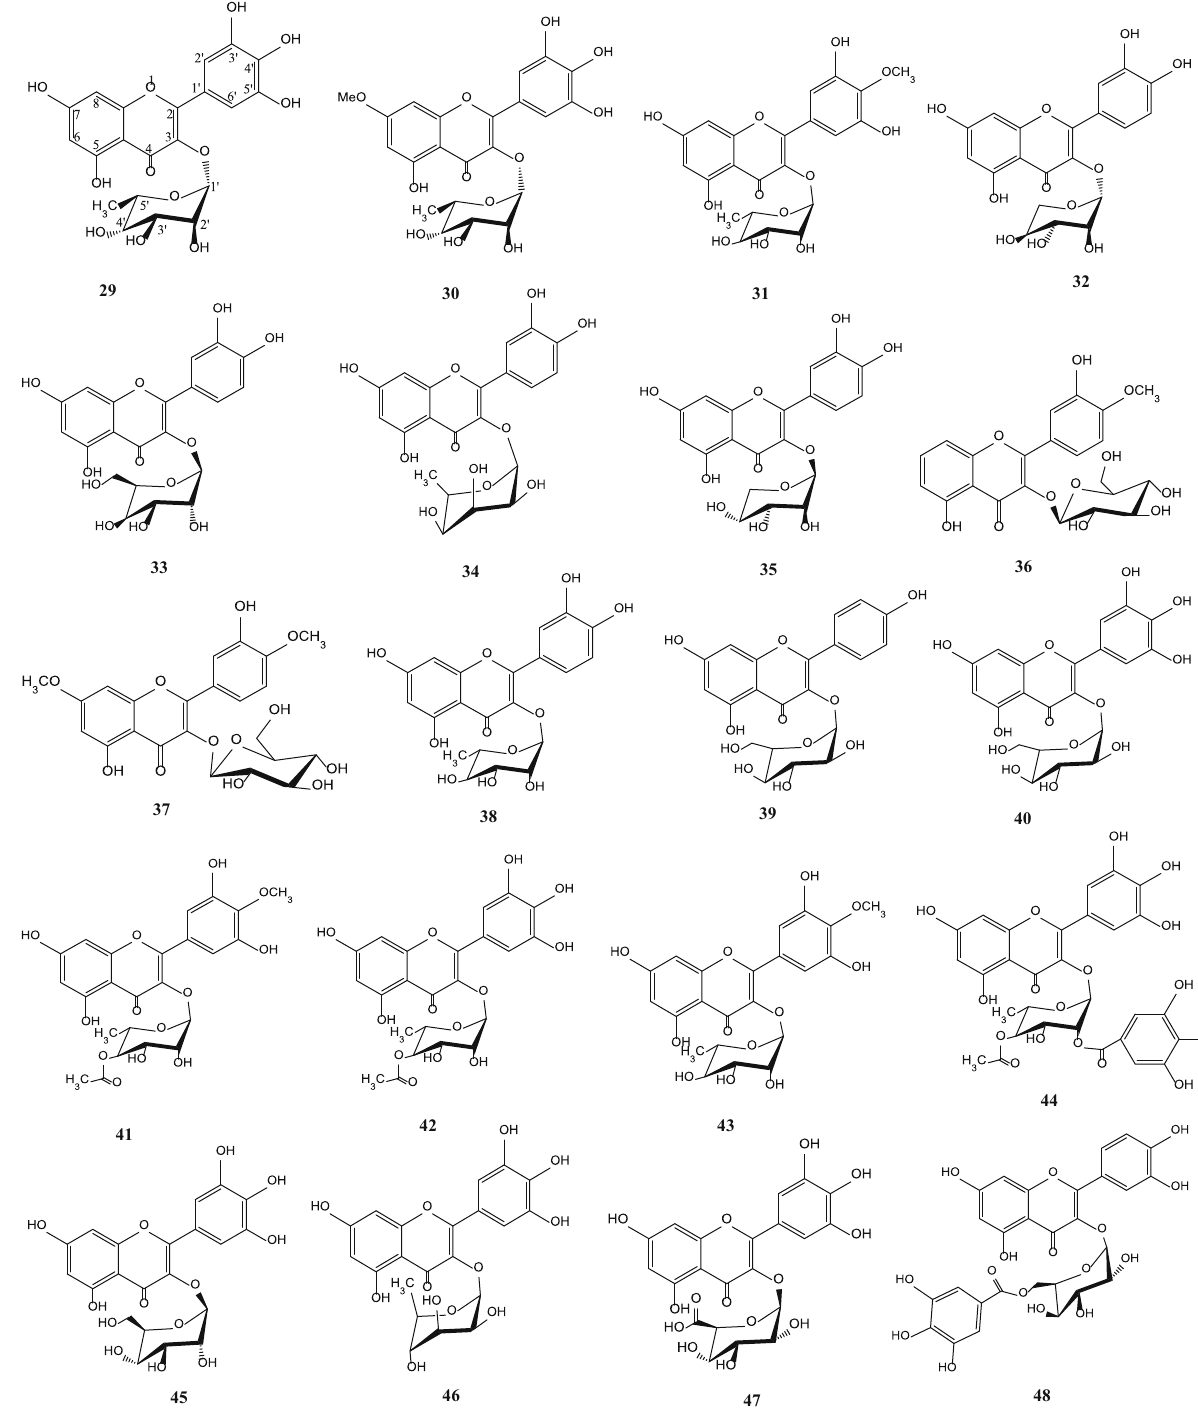
Figure 2: Flavonoid glycosides from various parts of S. aqueum , S. samarangense , S. aromaticum , S. cumini and S. guineense